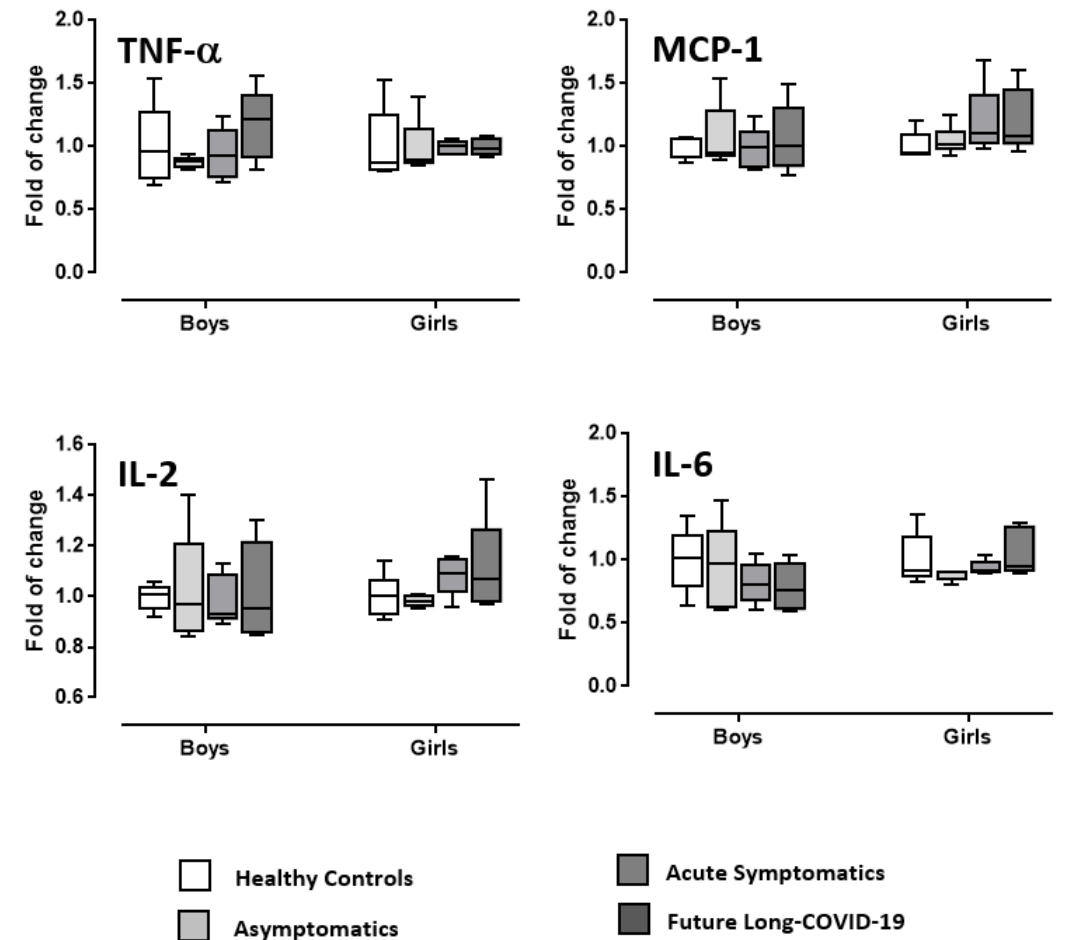
Figure 4. Serum TNF- α , MCP-1, IL-2, and IL-6 in COVID-19 adolescents and healthy controls. Ac- cording to their COVID-19 related outcomes, the recruited individuals were divided into 3 groups: asymptomatics, acute symptomatics, symptomatics that over time developed long-COVID-19 symp- toms (“future long-COVID-19”); as a control group we analyzed the serum of age-matched healthy controls that did not contract the infection. Boxes indicate the lower and upper quartiles. The vertical lines extending from each box represent the minimum and maximum values.